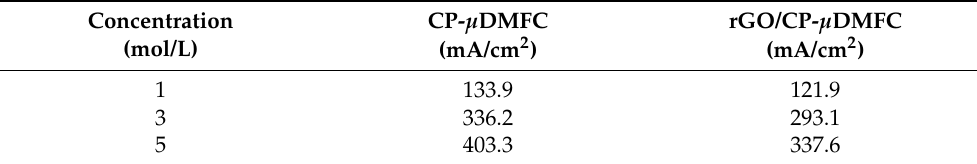
Table 4. Peak methanol crossover current densities of the rGO/CP- µ DMFC and the CP- µ DMFC at different methanol